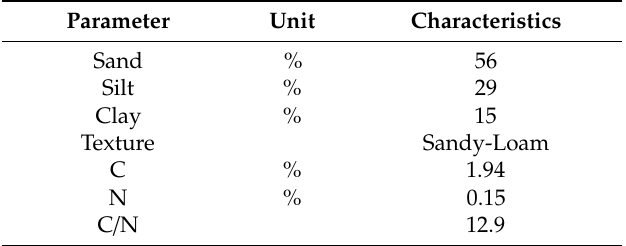
Table 2. Physical–chemical properties of the soil prior to sowing at 0–10 cm